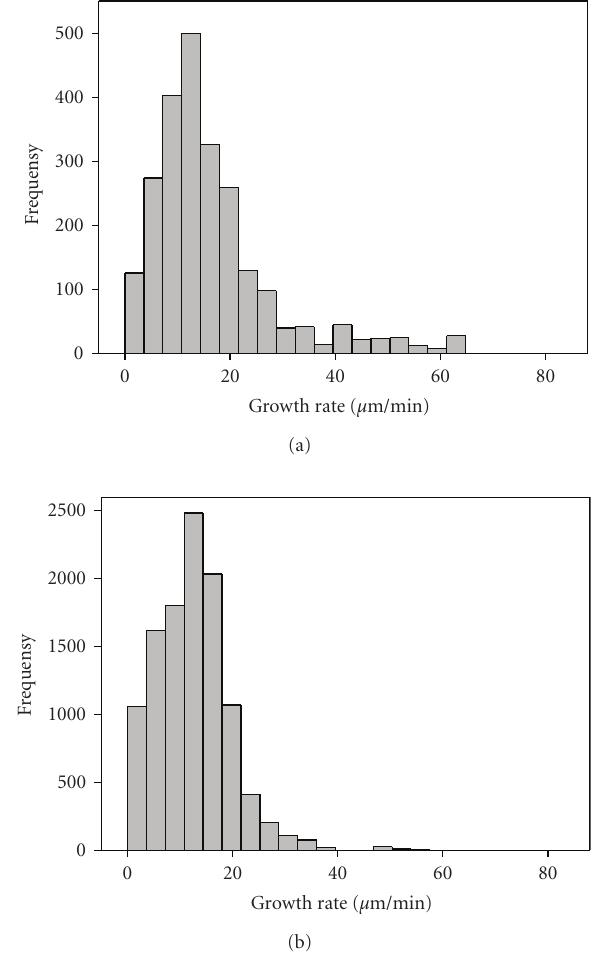
Figure 3: Microtubule plus-ends growth rates are di ff erent in centrosome region and on the periphery near the cell margin. Growing microtubule plus-ends were selectively marked in human EC. HPAEC were transfected with the plasmid expressing EB3-GFP. Persistent microtubule growth was confirmed by long EB3-GFP tracks. EB3-GFP movement was analyzed by time-lapse